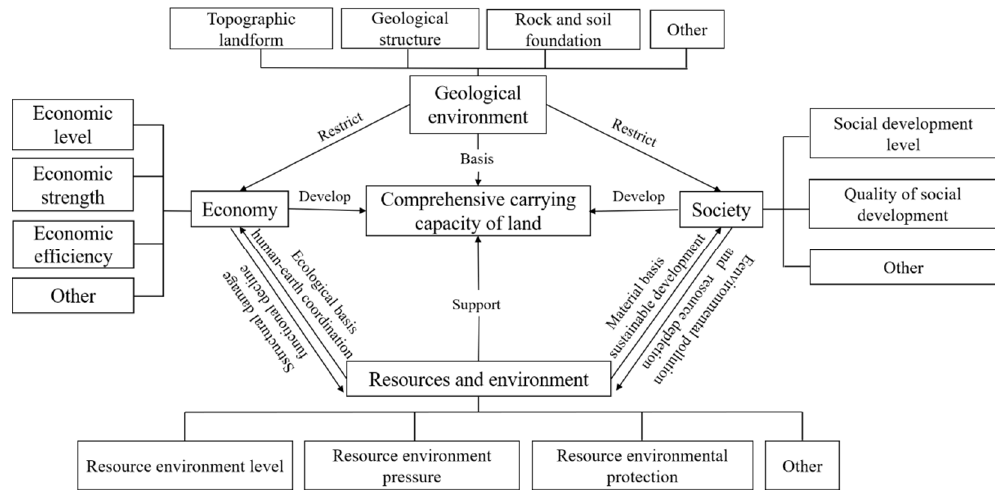
Figure 1. Theoretical framework of LCCC.